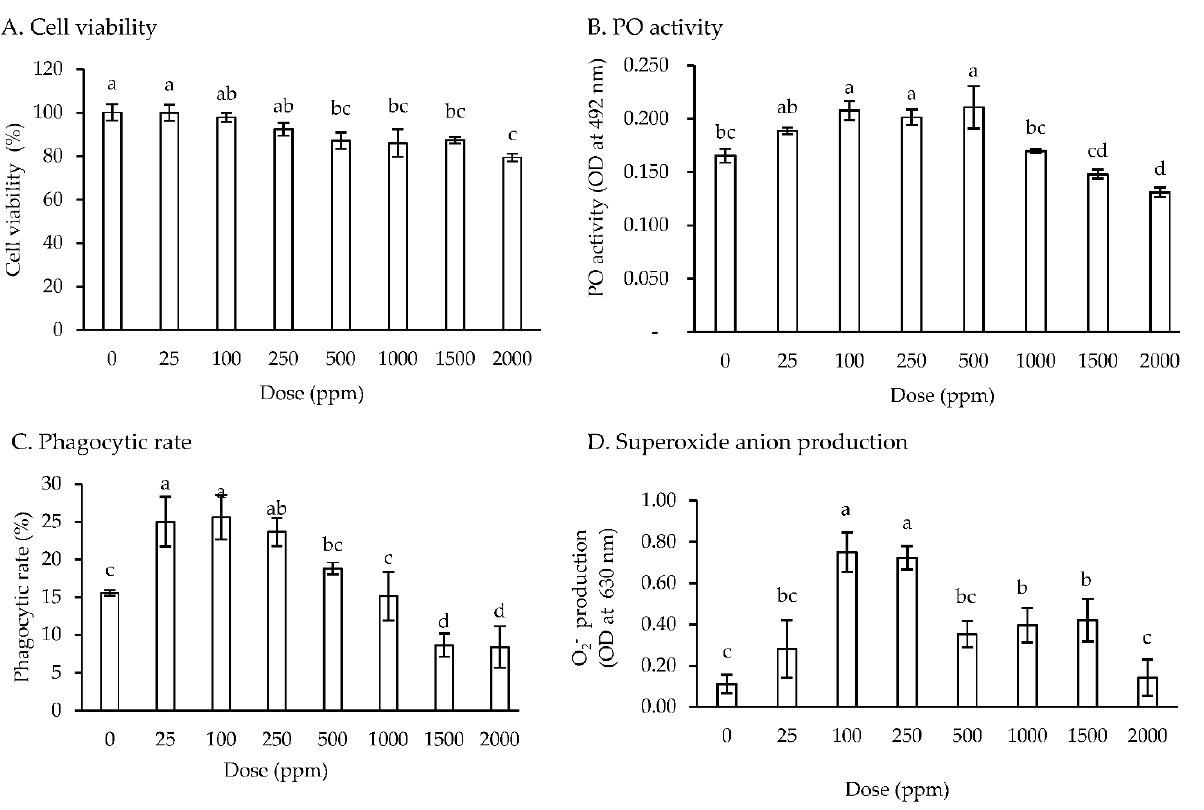
Figure 1 . In vitro assay. The effect of different concentrations (0, 25, 100, 250, 500, 1000, 1500, and 2000 ppm) of moringa extract on cell viability, PO (phenoloxidase) activity, phagocytic rate, and superoxide anion production in the hemocytes of whiteleg shrimp. The values represent the means. The error bars indicate ± standard deviation ( n = 3). Bars with different letters are significantly different ( p < 0.05).